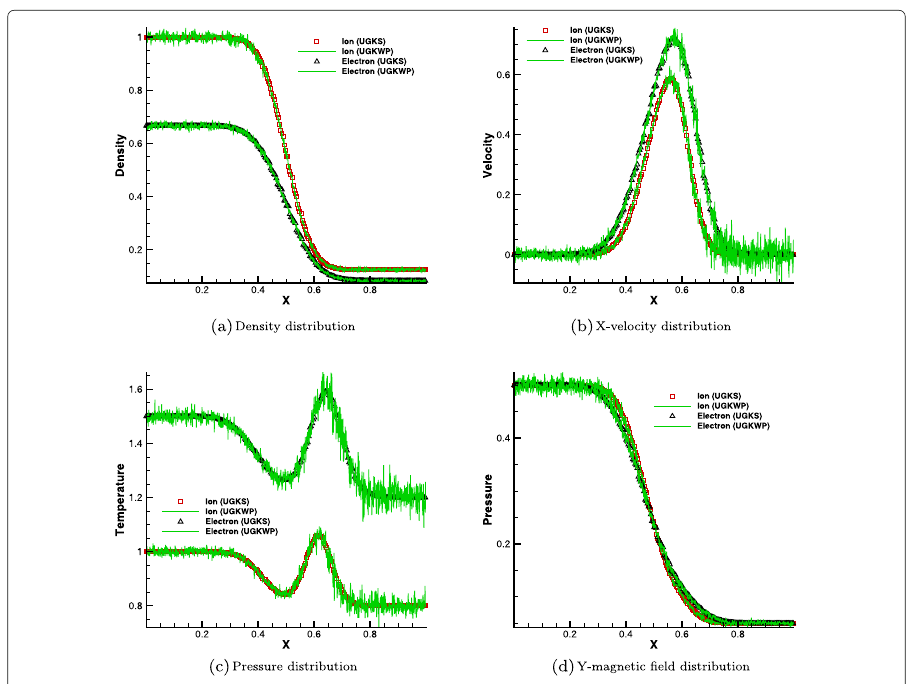
Fig. 8 Multiscale Brio-Wu shock tube problem with Kn=1 and r 10 3 . Lines show the UGKWP solutions and symbols show the reference UGKS